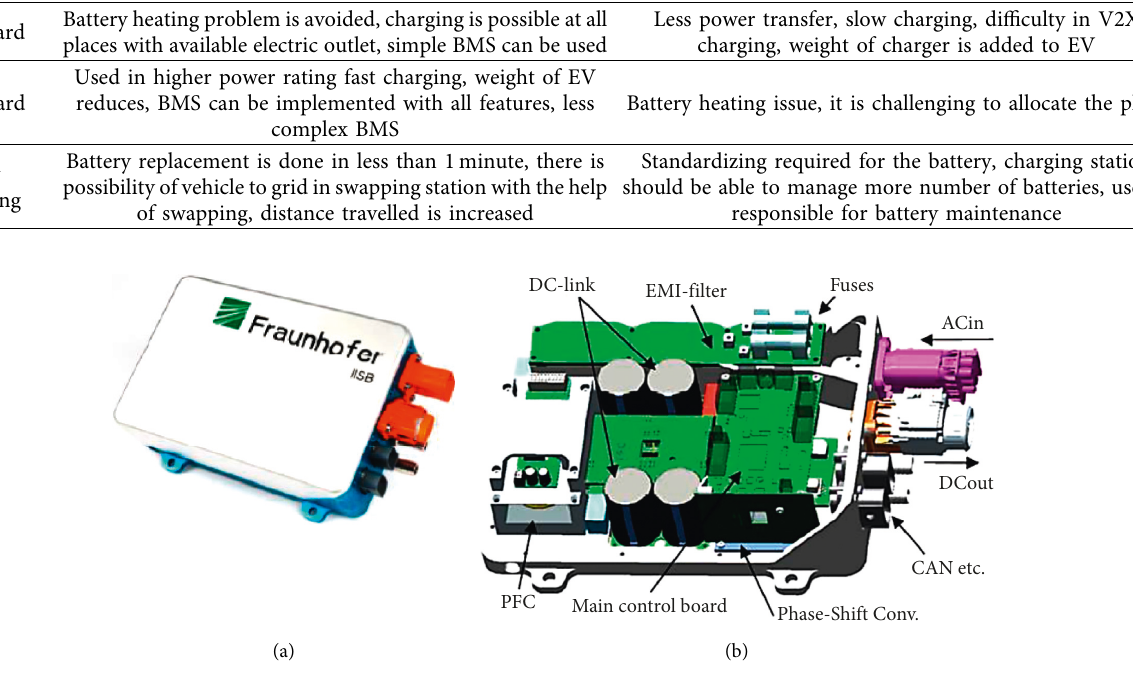
Figure 23: (a) 3.7kW on-board charger. (b) Internal component organization of the 3.7 kW charger